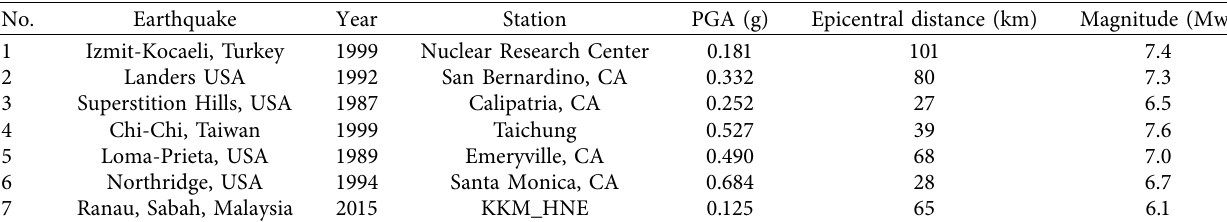
Table 3: Selected sets of ground motion records.